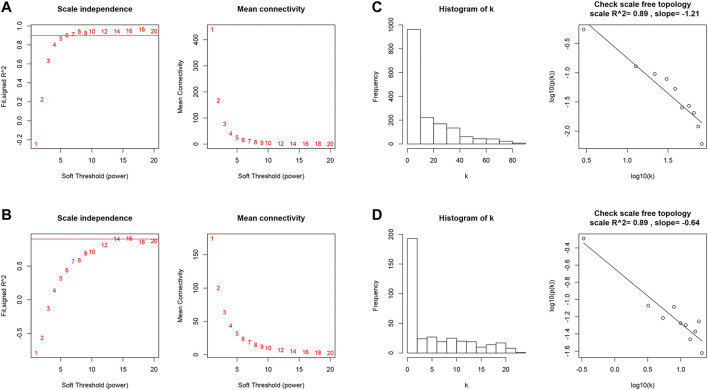

(A and B) Analysis of the scale-free fit index and the mean connectivity for various soft-thresholding powers of TCGAMIBC and GSE13507 datasets. (C and D) Checking the scale-free topology when β = 6 and 14. K shows the logarithm in the whole network connectivity, p
(
k
) represents the logarithm of the corresponding frequency distribution. K is negatively correlated with p
(
k
). The correlation coefficient was 0.89 in both TCGAMIBC and GSE13507 datasets, which represents scale-free topology.